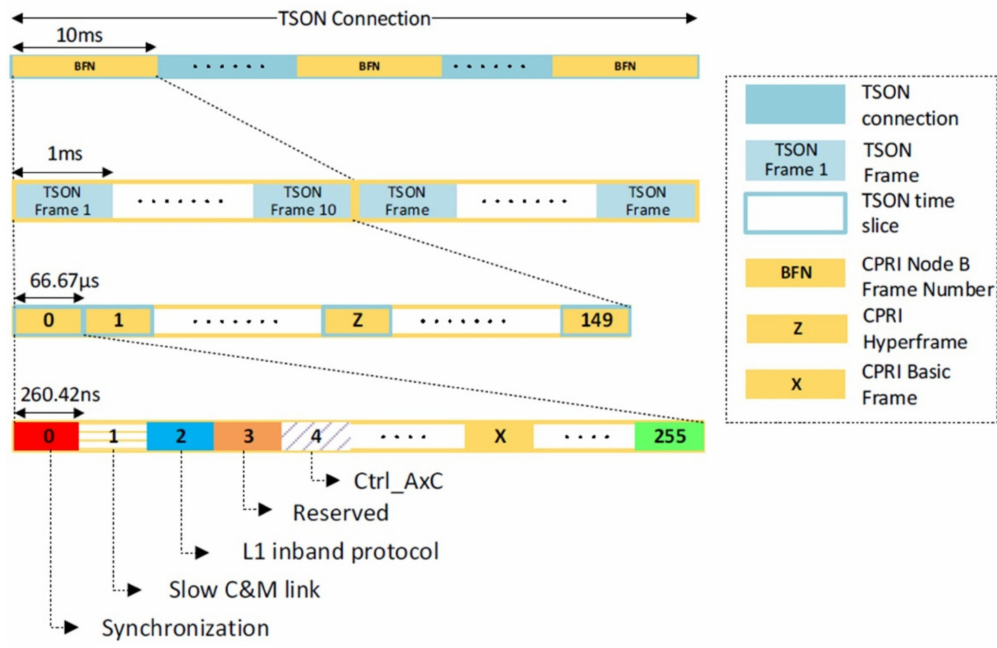
Figure 6. Common public radio interface (CPRI) frame structure over TSON. C&M: control and management, L1: layer 1, Ctrl_AxC: control data stream for antenna carrier, BFN: node B frame number.